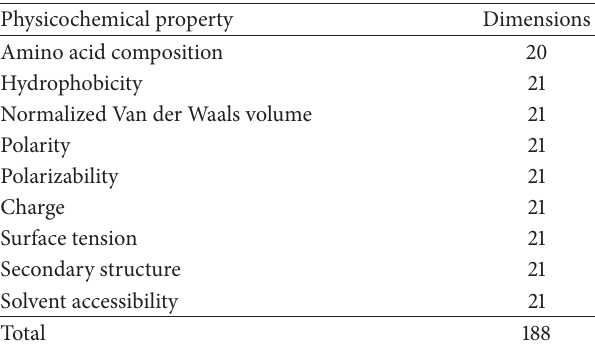
Table 2: The composition of 188D features of a